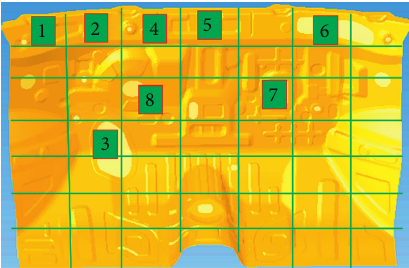
Figure 3: SEA model of dash panel. Table 1: Subsystem of dash